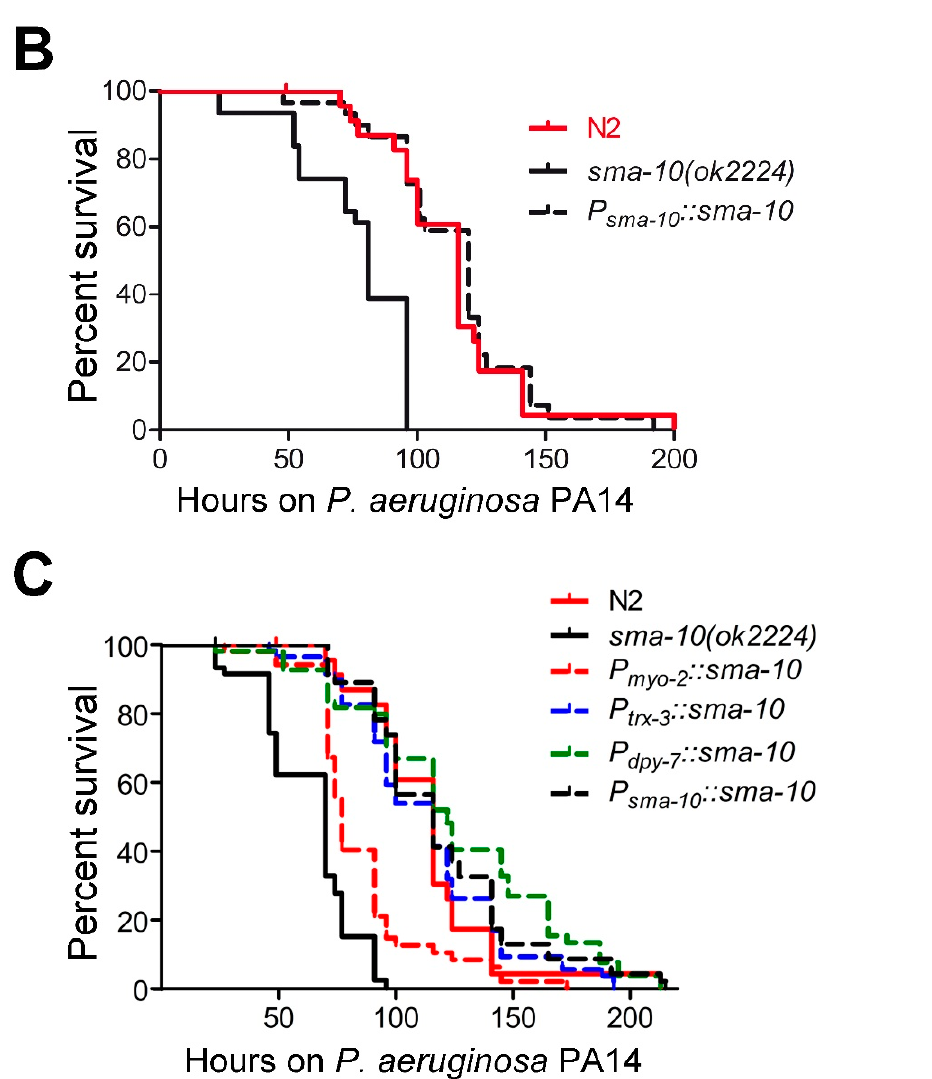
Figure 4. The expression of SMA-10 in intestine and hypodermis is required for the immune response to infection by Pseudomonas aeruginosa (strain PA14) independently from DBL-1. Kaplan–Meier plot was used to show the fraction of animals that survived overtime to PA14 infection; data shown are from one representative experiment. ( A ) sma-10(ok2224) mutants are more sensitive to PA14 infection than the wild-type, whereas dbl-1(nk3);sma-10(ok2224) animals survive even less than sma-10(ok2224) or dbl-1(nk3) , suggesting an independent function of SMA-10 with respect to DBL-1 in relation to immunity. ( B ) The entopic overexpression of SMA-10 (with its own promoter) rescued the deficient response to PA14 infection of sma-10(ok2224) worms, indicating its unequivocal role in immunity. ( C ) Wild-type SMA-10 expressed from endogenous, intestinal ( P trx-3 ) or hypodermal ( P dpy-7 ) pro- moters fully rescued the sma-10(ok2224) mutant phenotype, whereas a restricted pharyngeal ( P myo-2 ) expression only produces a partial